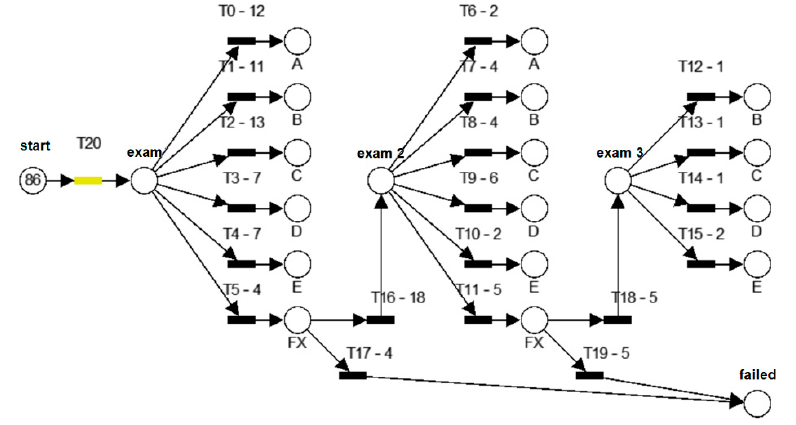
Figure 11. Model of the final exam in Petri Nets.